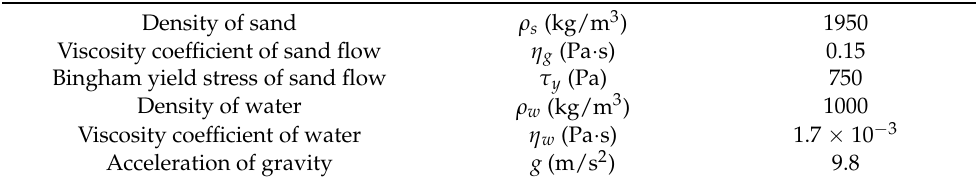
Table 3. Parameters used in the SPH simulation of underwater sand flow.